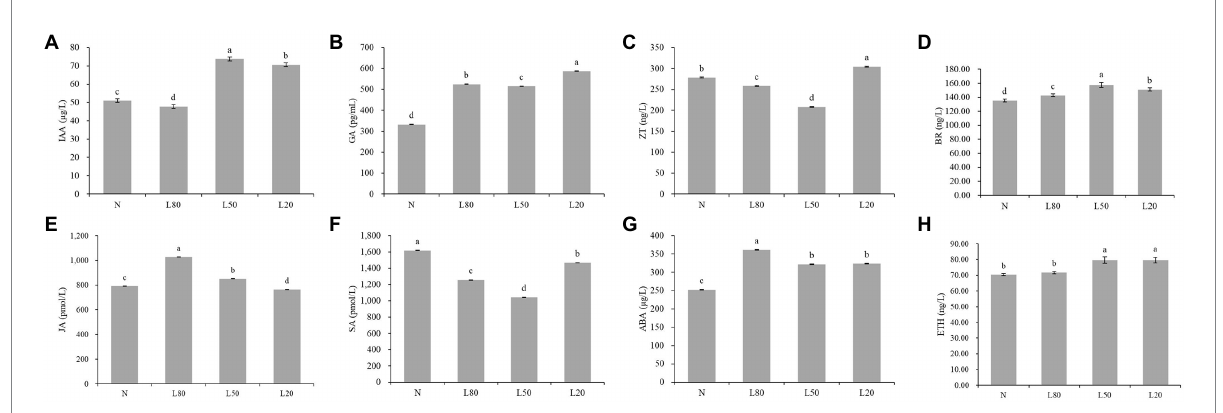
FIGURE 2 Changes in plant hormone content of J. mandshurica under shade. (A) IAA. (B) GA. (C) ZT. (D) BR. (E) JA. (F) SA. (G) ABA. (H) ETH. N: natural sunlight. L80: 80% sunlight to go through. L50: 50% sunlight to go through. L20: 20% sunlight to go through. The x-axis represents the samples, and the y-axis indicates the phytohormone content. Error bars indicate standard deviation (SD). Different letters indicate significant differences between different